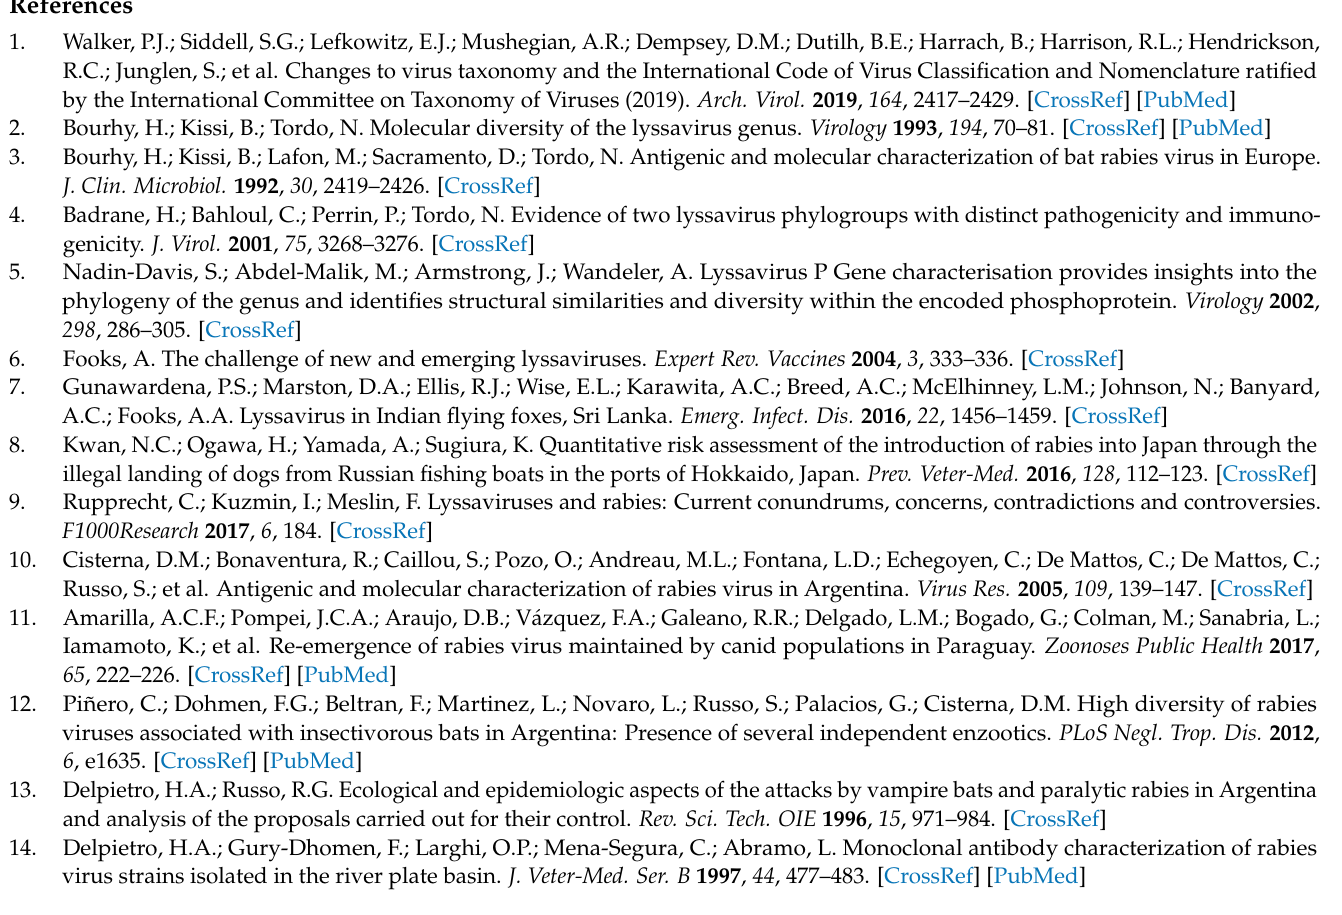
N gene and 51 bp downstream, Supplementary Figure S1: Schematic representation of primer sets and probes used in this